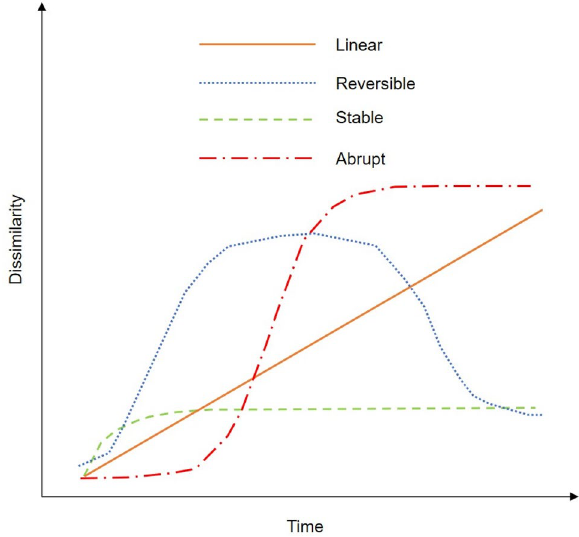
Figure 1. Conceptual diagram of four trajectories of community change (Bagchi et al. 2017) 5 . The y -axis represents the dissimilarity index of species composition between an initial time and each subsequent time. Each trajectory represents a different concept of community ecological resilience.